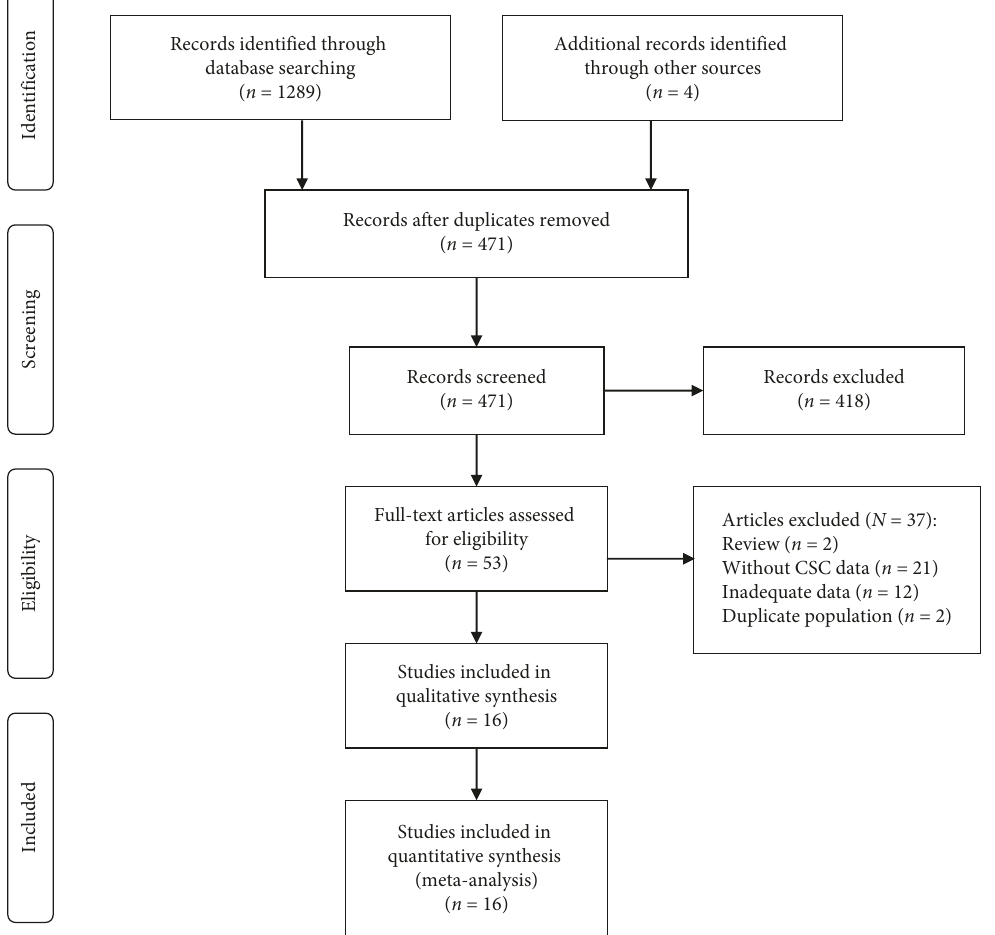
Figure 1: Diagram of study selection; CSC � cataract surgical